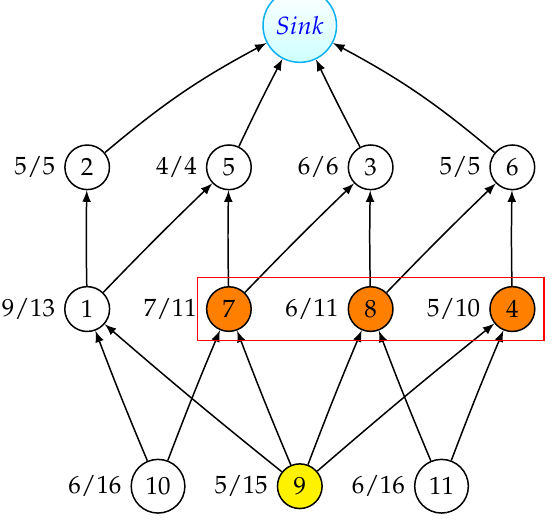
Figure 2. Node delay d and path delay D presented for each node on its left d / D . Node 9 top-list neighbors are 7, 8 and 4 encircled in